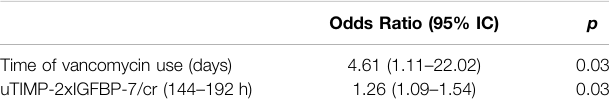
Non-kidney function recovery n = 11